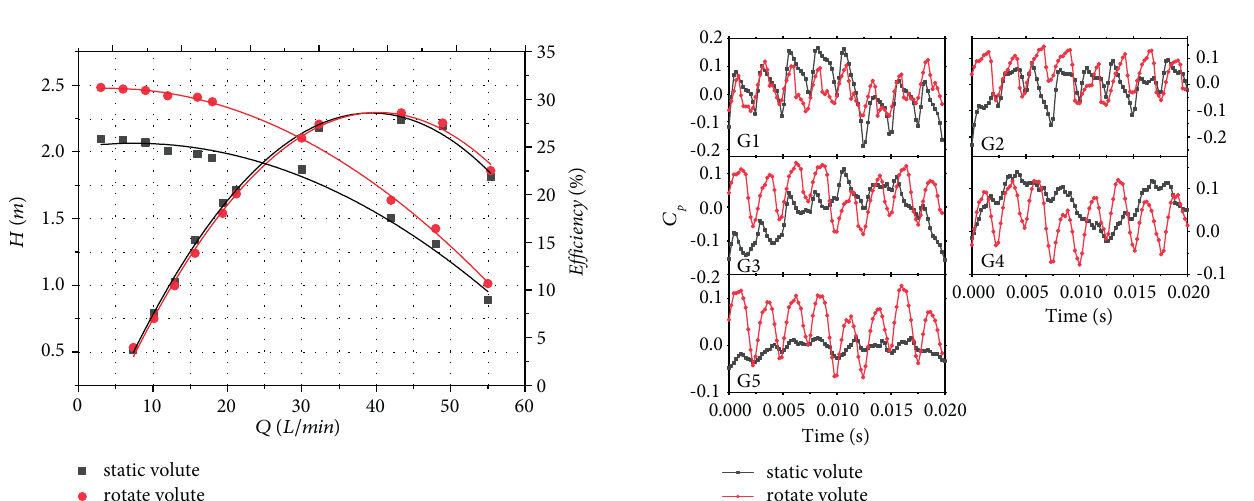
Figure 15: Time domain of the pressure pulsation at monitoring points